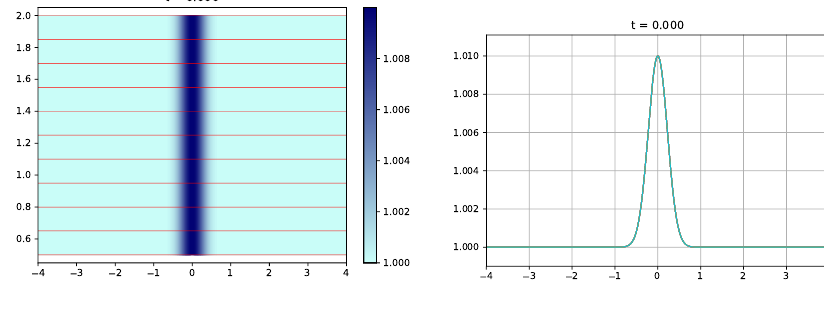
Figure 13. Relative density initial condition.